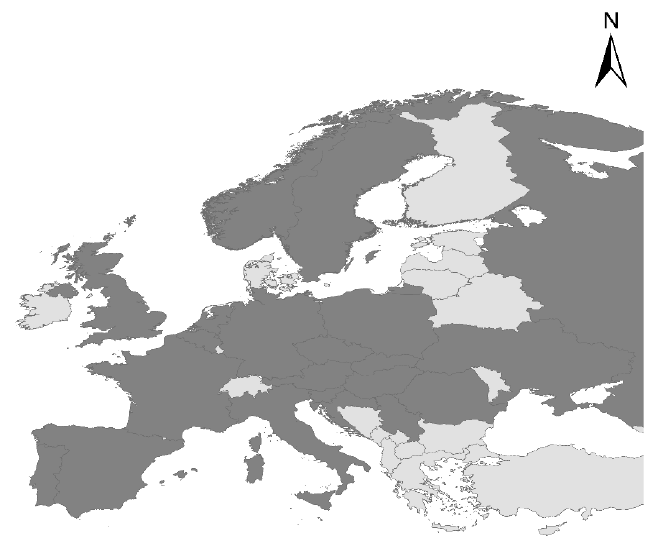
Figure 2. European countries where Pistia stratiotes has already been recorded are in grey. For details see Table 1. Table 1. Distribution of P. stratiotes within European countries and year of the first report. Country